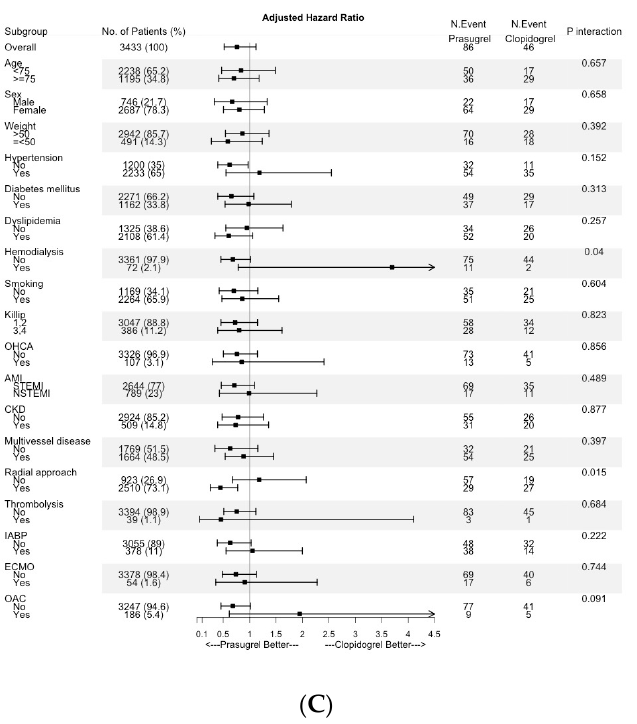
Figure 2. Results of a subgroup analysis of the efficacy endpoint (ischemic events, ( A )), safety endpoint (bleeding events, ( B )), and composite endpoint (composite of ischemic and bleeding events, ( C )).